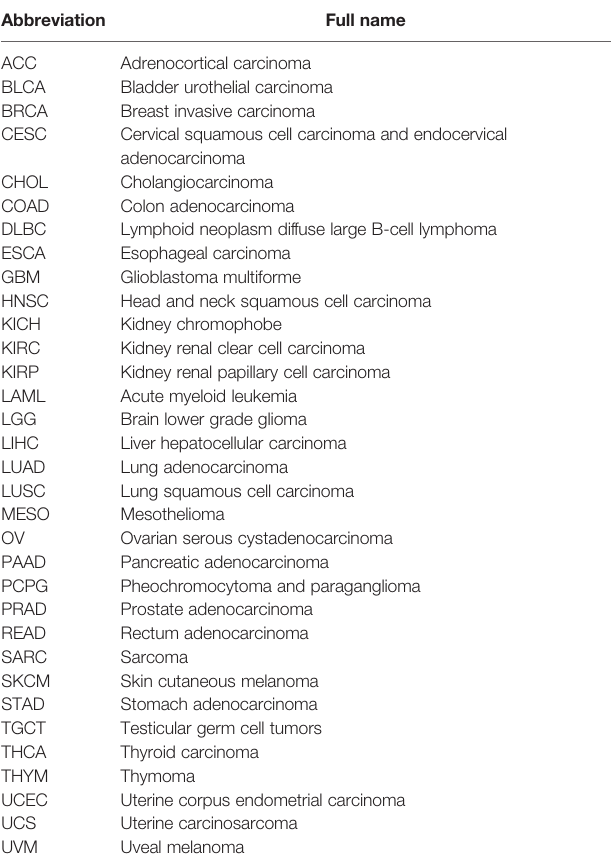
TABLE 1 | 33 types of human cancers employed in our